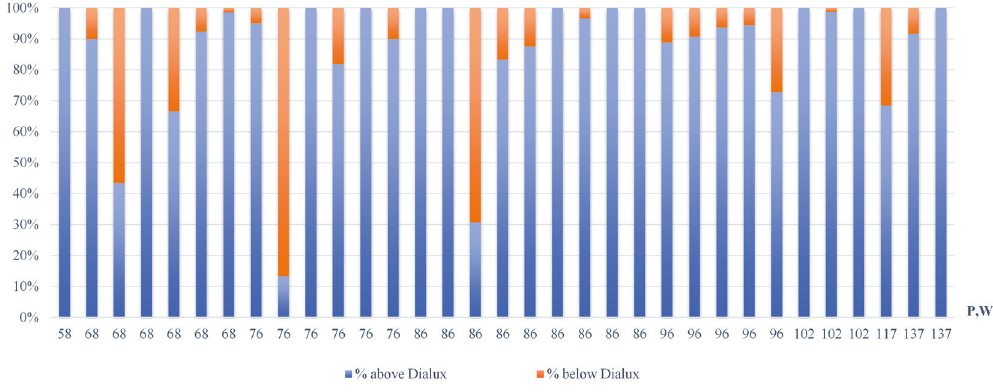
Figure 18. Measured value comparison with Dialux 4.13 obtained result values by luminary power